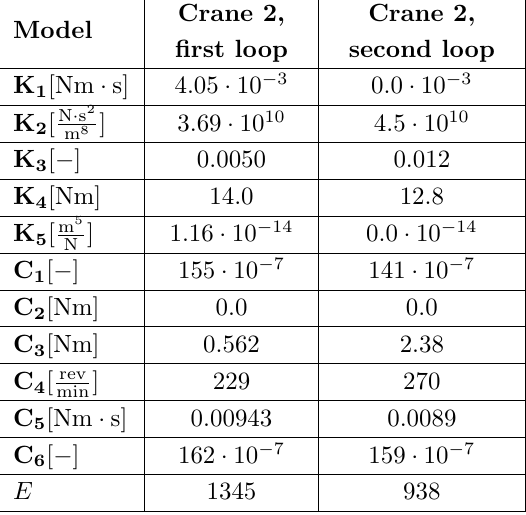
Table 4: Optimized friction parameters